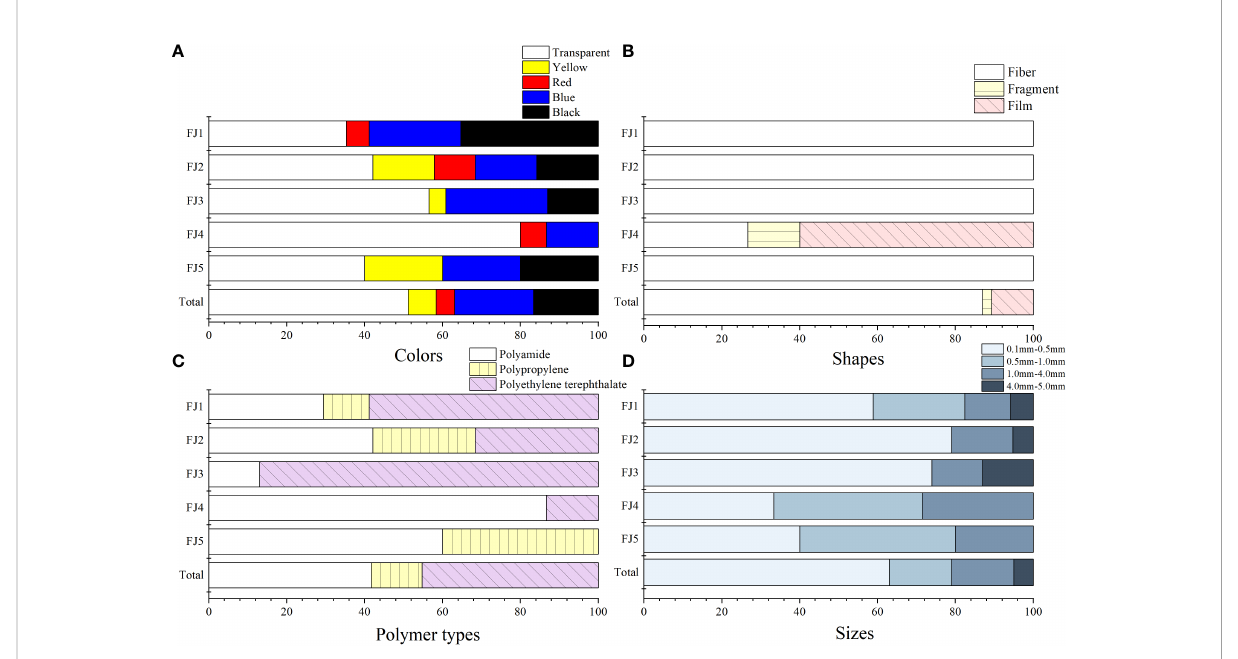
FIGURE 3 Various MPs were found in fi nless porpoises. (A) The colors composition; (B) The shapes composition; (C) The polymer types; (D) The sizes composition and